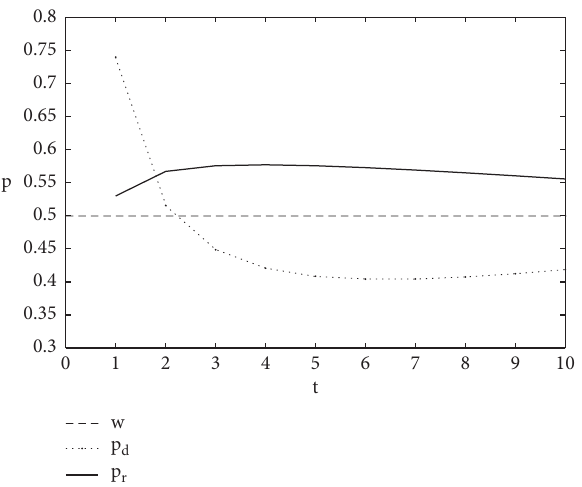
Figure 4: Effect of t on